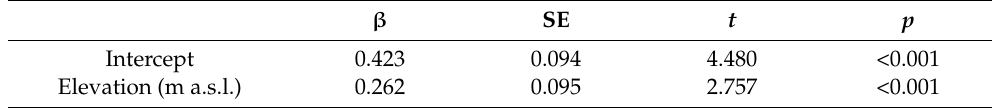
Table 2. Factors influencing the harvesting rate of Olea europaea (Wall. ex G. Don) Cif. in Hugumburda dry Afromontane forest in northern Ethiopia. Also shown are the parameter estimates ( β ) and associated standard errors and t -values for a linear model of the relationship between O. europaea harvesting rate and the explanatory variables retained in the final model (Y = 0.423 + 0.262 x , R 2 = 0.11). β SE t